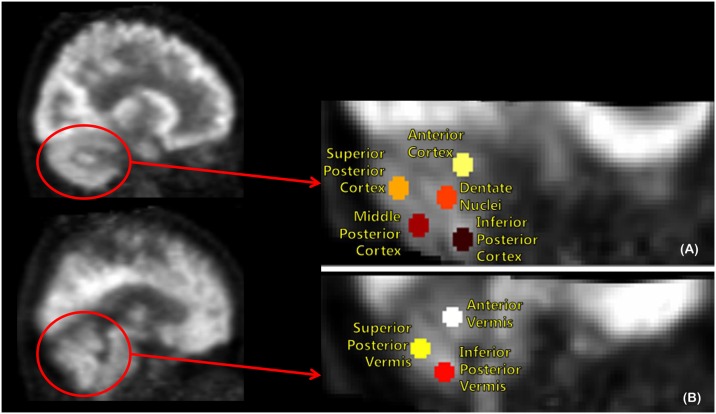
Volume of Interest (VOI) template on the cerebellum of a normal sagittal 18F-FDG PET image includes 13 VOIs in bilateral anterior cortex, superior/mid/inferior posterior cortex, dentate nuclei (A), anterior vermis, and superior/inferior posterior vermis (B).